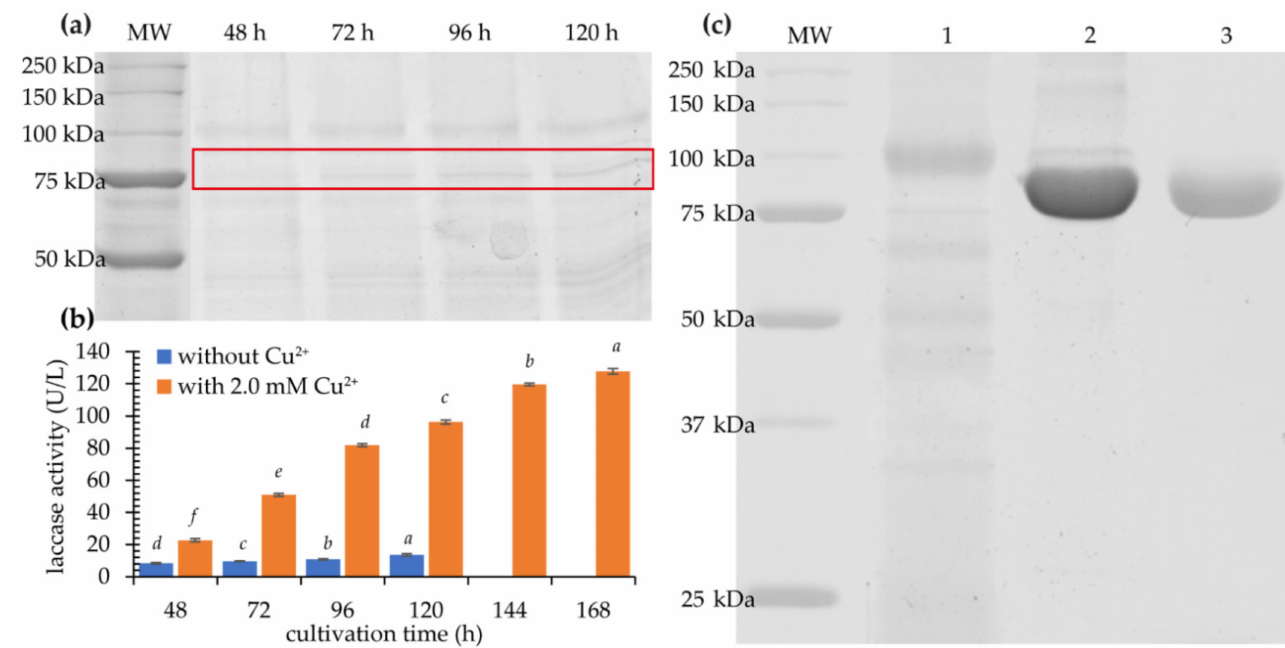
Figure 4. SDS-PAGE of the recombinant protein; ( a ) laccase KbLcc1 production after 48, 72, 96 and 120 h cultivation of P. pastoris in expression medium BMMY (without Cu 2+ ); KbLcc1 laccase bands were indicated by the red frame; ( b ) increase of laccase KbLcc1 activity during cultivation time in medium without and with copper supplementation (2.0 mM Cu 2+ ); the data presented as the means ± SD from at least three independent experiments; the means that are marked with different letters ( a – d for data series without Cu 2+ and a – f for data series with 2.0 mM Cu 2+ ) are significantly different ( p < 0.05); ( c ) purification of KbLcc1, 1: ultrafiltrated crude post-culture supernatant after 168 h of expression with 2.0 mM Cu 2+ ; 2: fraction after salting-out using ammonium sulfate; 3: purified KbLcc1; MW: molecular weight